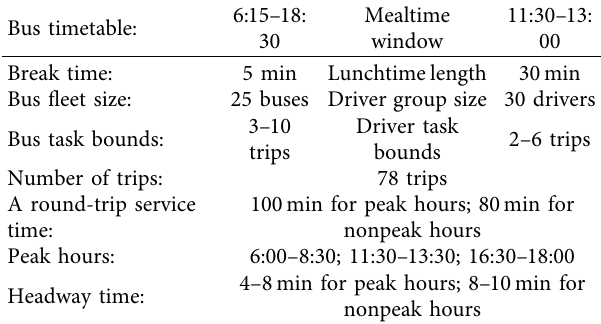
Figure 13: Effect of the bus fleet size on the charging cost. Table 3: Detailed information of the corresponding